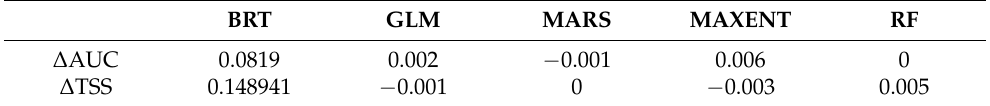
Table 4. Values of ∆ AUC e ∆ TSS for the different